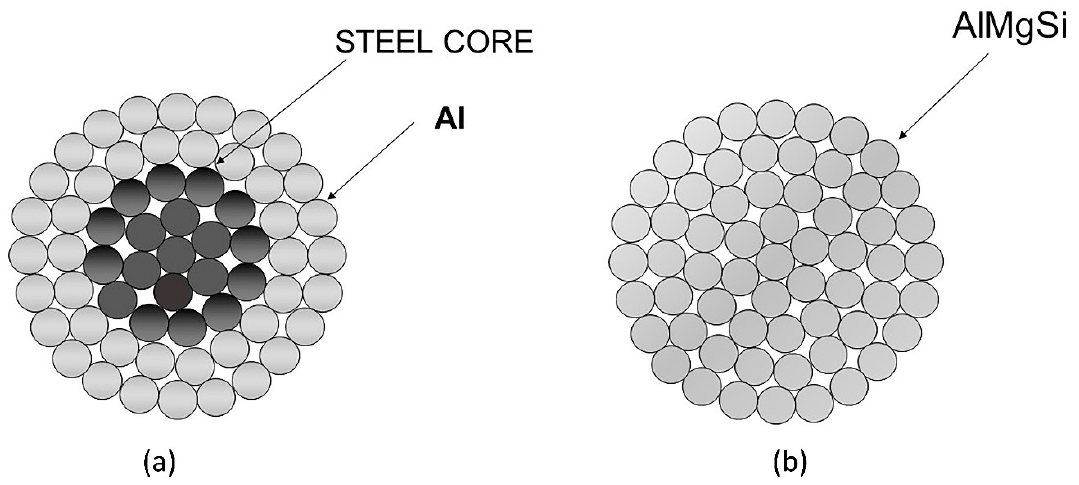
Figure 1. Aluminum conductor steel reinforced (ACSR) ( a ) and all aluminum alloy conductors (AAACs) ( b ).